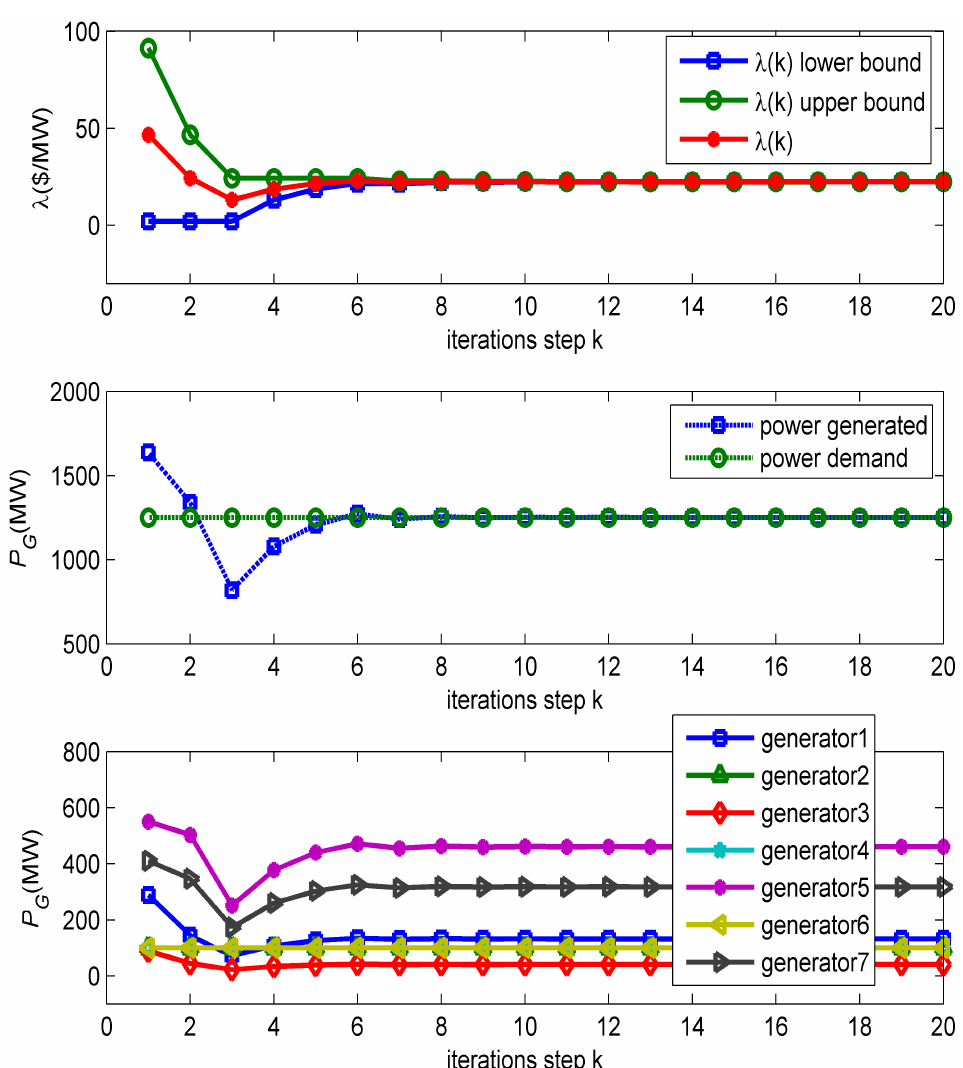
Figure 7. Case 3: IEEE 57-bus test system.